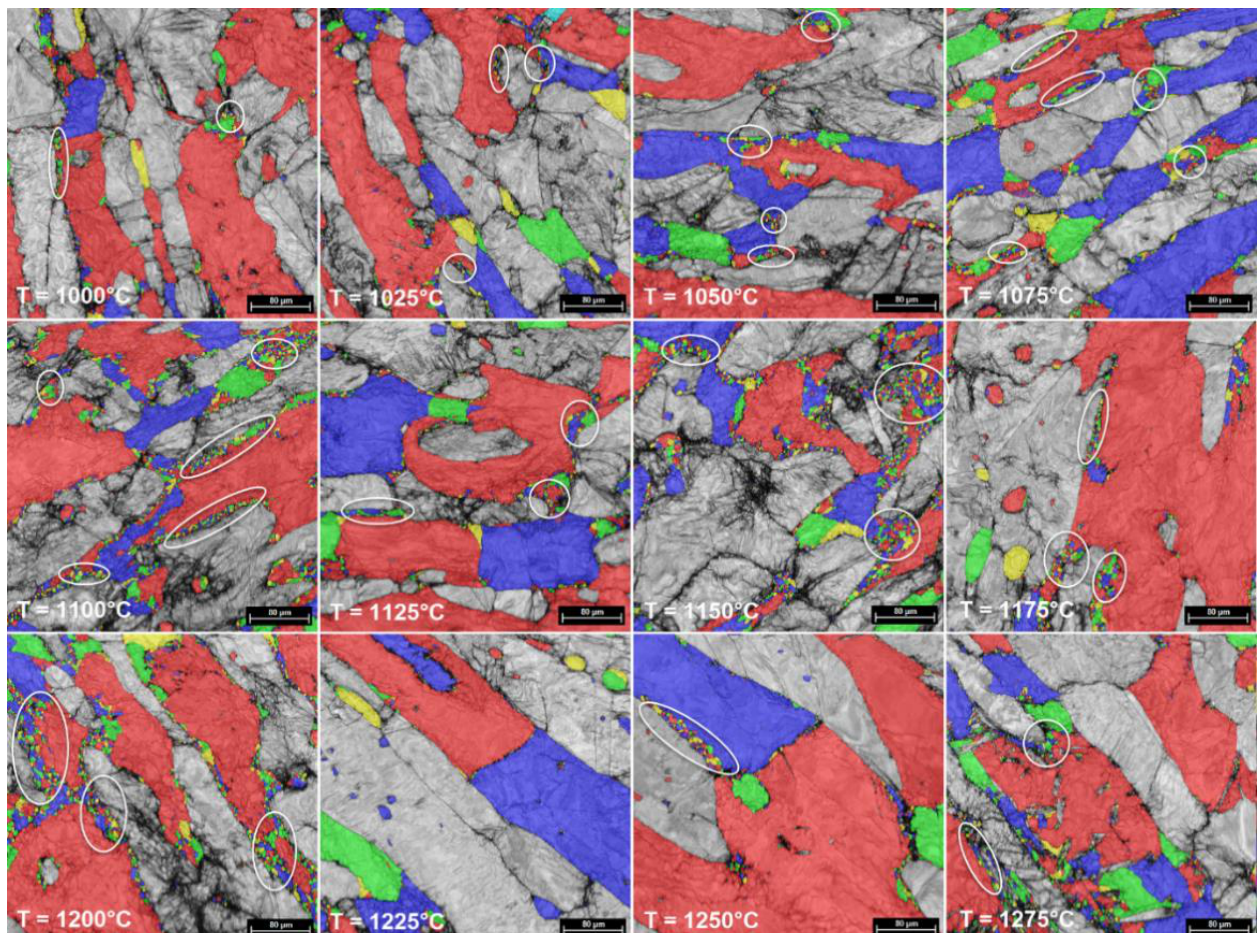
Figure 7. Typical random-colorized δ-phase grain size distribution maps in hot-deformed UNS S32750 SDSS alloy (from 1000 °C to 1275 °C).